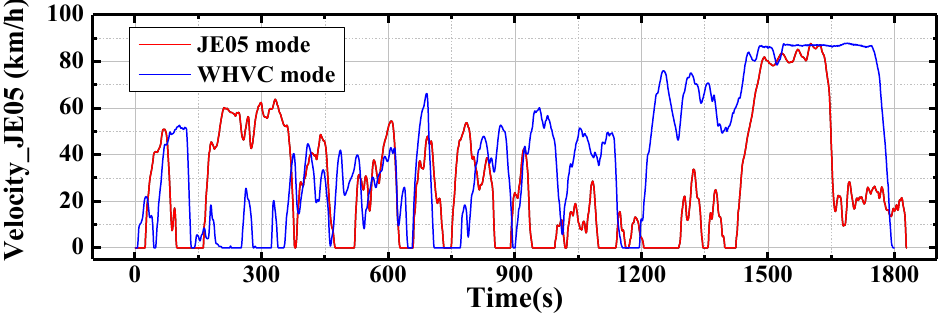
Figure 2. Driving mode data (JE05 & WHVC